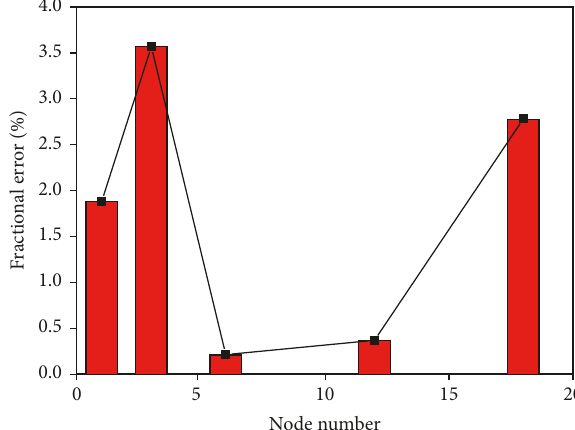
Figure 8: The influence of pressurizer node number on the frac- tional error between calculated and designed primary loop pressure.